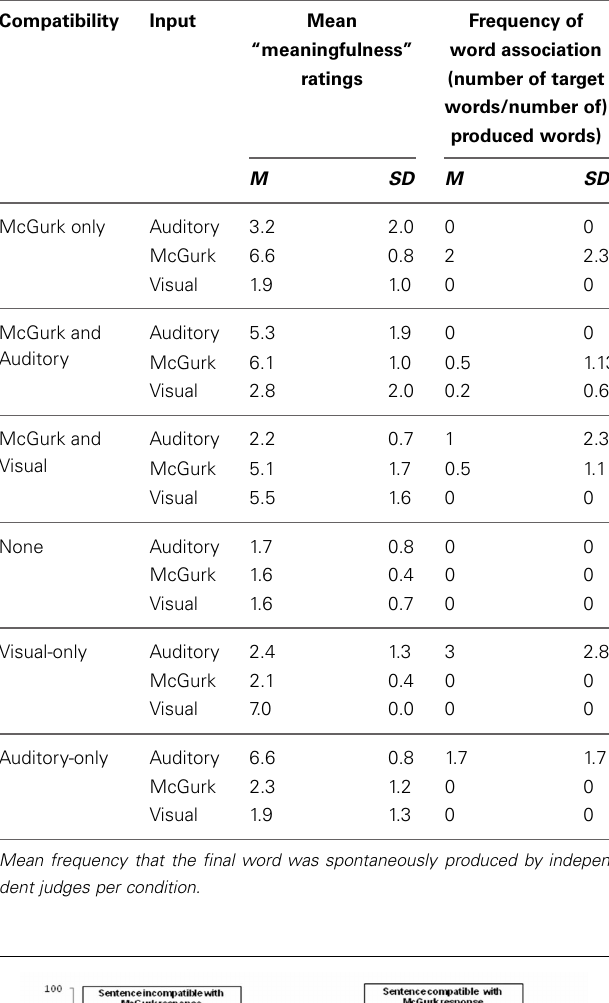
Table 3 | Mean rating of “meaningfulness” for the sentences in Experiment 2 in each condition.